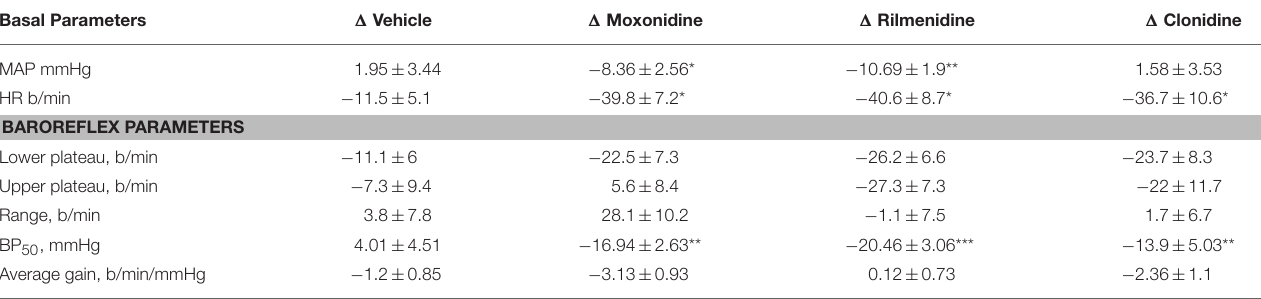
TABLE 6 | Comparison of chronic effect of moxonidine, rilmenidine and clonidine on sympathetic baroreflex curve parameters compared to vehicle. Basal Parameters